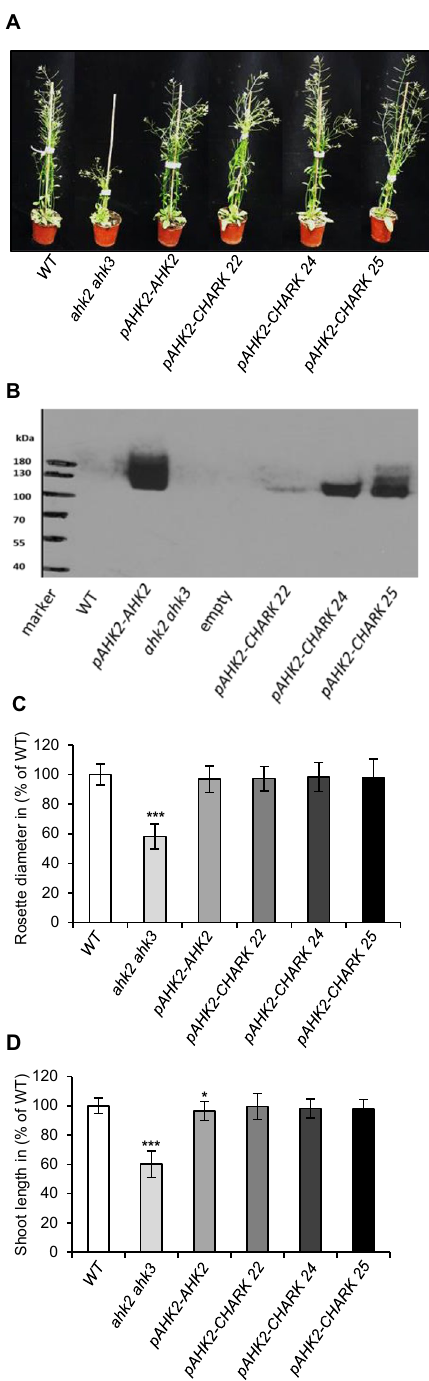
Figure 5. CHARK complements functionally the A. thaliana receptor mutant line ahk2 ahk3 . ( A ) Complementation of the ahk2-2 ahk3 - 3 mutant by pAHK2-AHK2 28 (positive control) or pAHK2-CHARK . Three independent homozygous lines containing pAHK2-CHARK were tested. Plants shown are 25 days old. ( B ) The expression of the AHK2-myc and CHARK-myc fusion proteins was detected by protein blot analysis using a myc antibody. ( C , D ) Rosette diameter and shoot length of WT, ahk2-2 ahk3 -3, pAHK2-AHK2 and the three lines expressing CHARK . The experiments were repeated twice. Data represent mean values ± SD ( n ≥ 24). The significance of differences compared to WT were calculated using Student’s t-test. * P < 0.05; *** P <